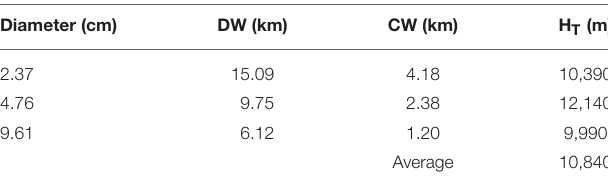
TABLE 2 | Isopleth data obtained from field data interpolation, through the method of Carey and Sparks (1986). Diameter